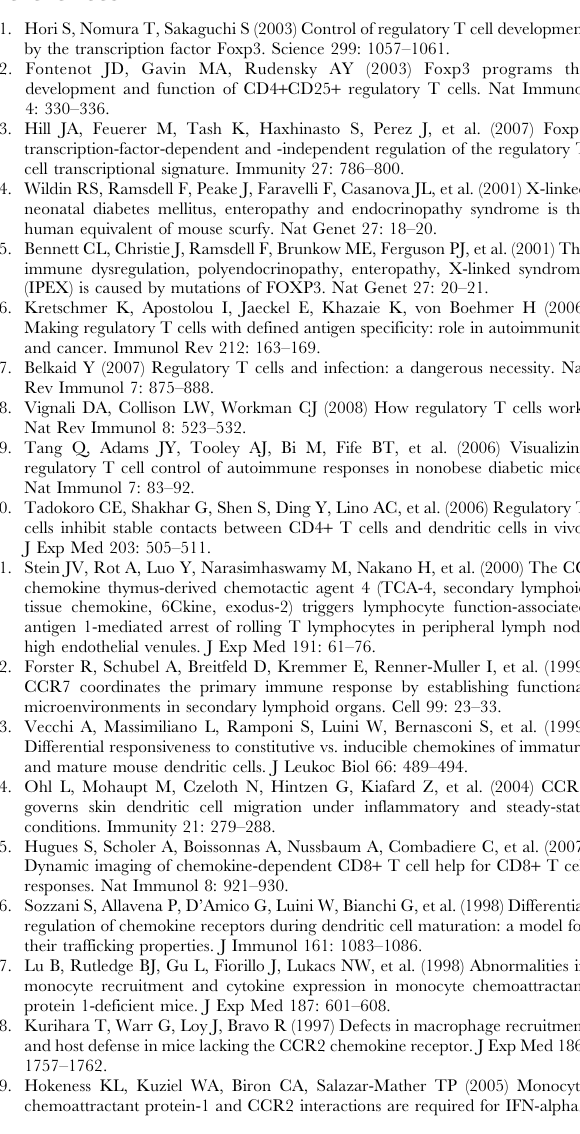
specific T cells. Mice were adoptively transferred with CFSE- labelled 6.5 + cells and one day later were injected with CMTMR-